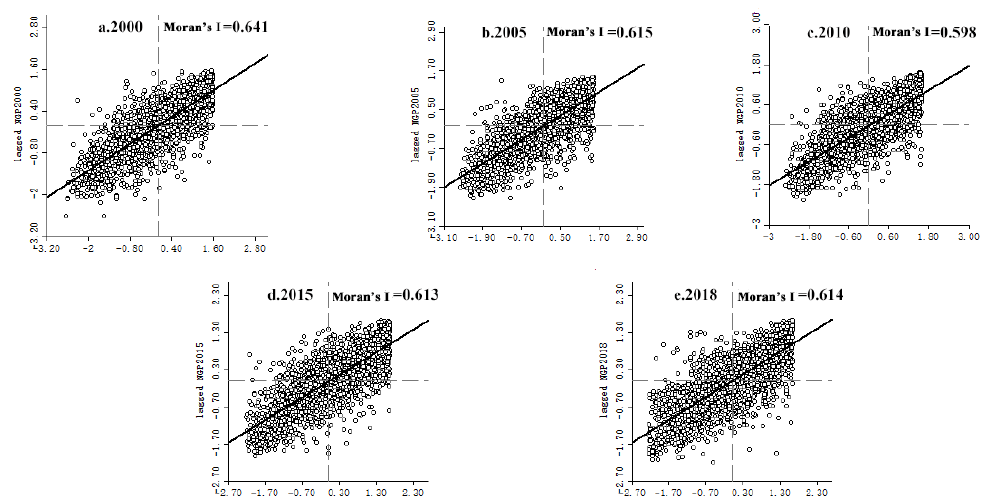
Figure 4. Moran’s I scatter plot of non-grain production rate.